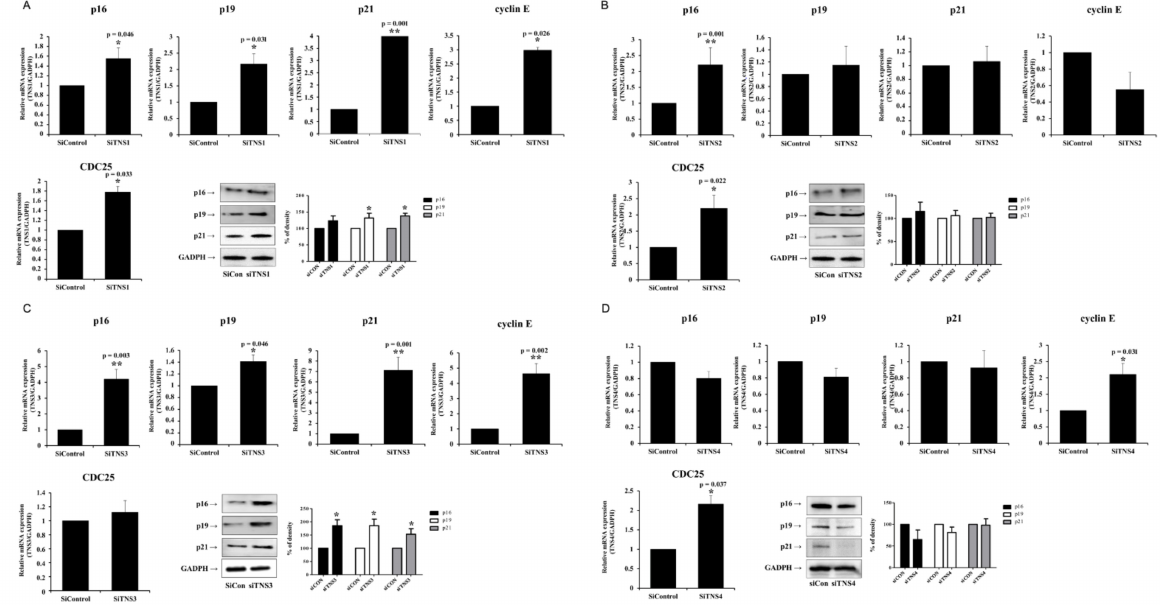
Figure 2. Tensin1 and 3 control cell-cycle regulators in tonsil mesenchymal stem cells. After siTNS1 ( A ) and siTNS3 ( C ) treatment, RT-PCR and Western blotting analysis confirmed the increased expres- sions of p16, p19, and p21. ( B ) No significant changes were observed in markers for cell-cycle arrest in siTNS2-treated cells. ( D ) After siTNS4 transfection, p16, p19, and p21 decreased slightly, but there was no significant difference. * p < 0.05 and ** p < 0.01, compared to siControl. n = 4. Columns and error bars represent mean ± standard